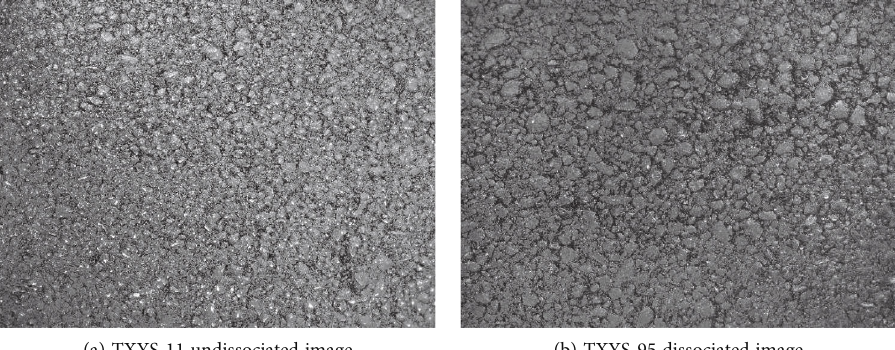
Figure 8: Raw photos from image acquisition.